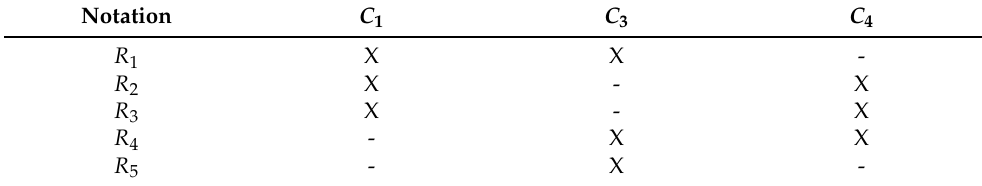
Table 7. Demonstration of optimum combinations of 2048 desktop and mobile applications.